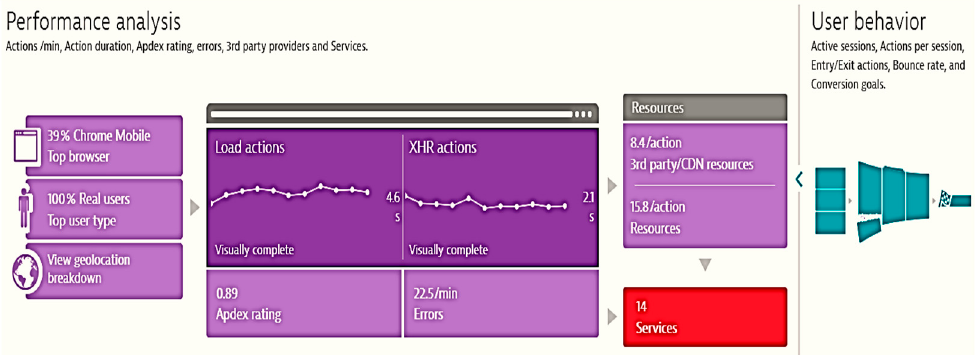
Figure 4. Extra information shown in application performance monitoring.